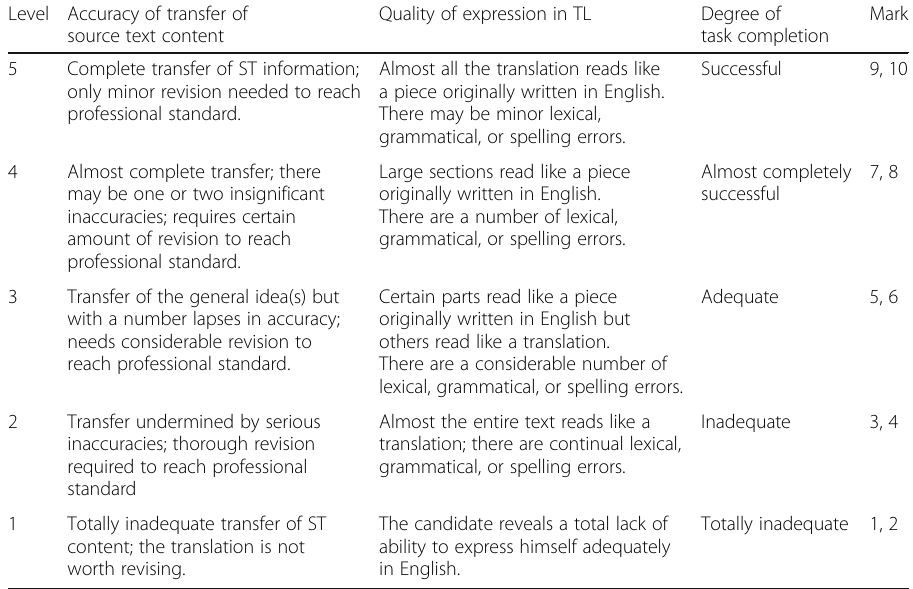
Quality of expression in TL Degree of